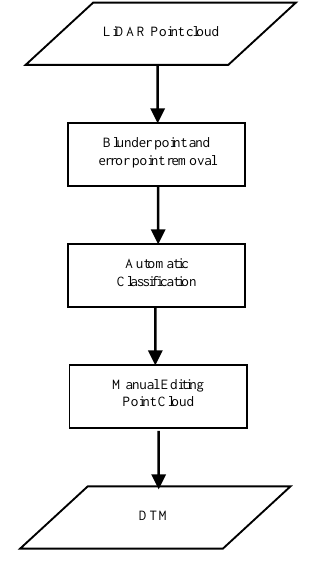
Figure 7. Flowchart making a DEM from LiDAR DEM